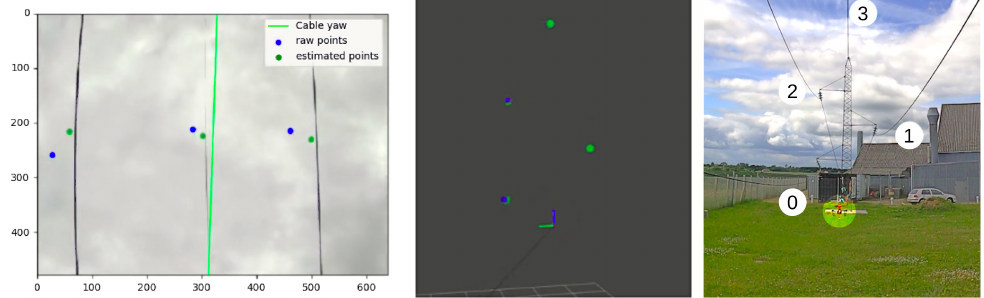
Figure 6. Visualization of cable detection data. Left: Onboard camera view with projected 3D radar data. The green line is the direction of the cables relative to the drone. Middle: Rviz2 visualization of 3D data and drone frame. Right: Drone position in a powerline test setup. The numbers are used to identify the different cables in the